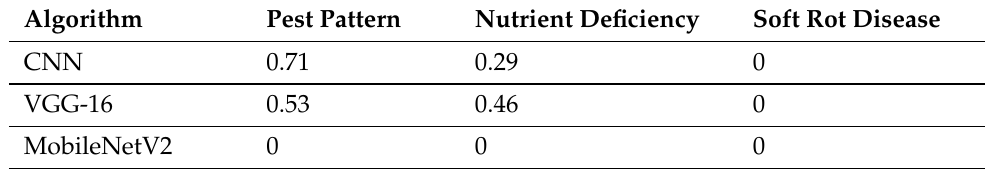
Table 3. Model evaluation in terms of the Mathews correlation coefficient